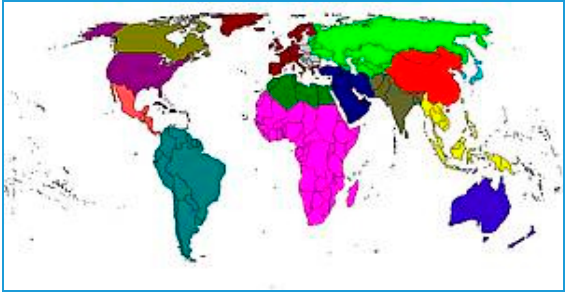
Figure 2. FUND regions. (Source: FUND Home [4]).